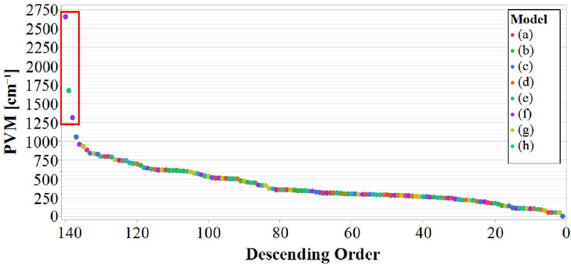
Fig. 4 PVM frequencies in descending order with outlying frequencies marked in red rectangle. Models ( a – h ) in the legend coincide with the order presented in Fig. 3.